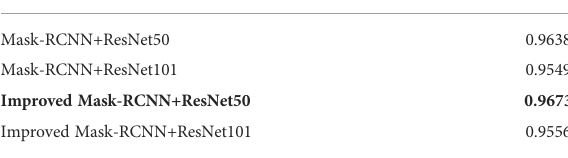
Bold values represent the best indicators in the current